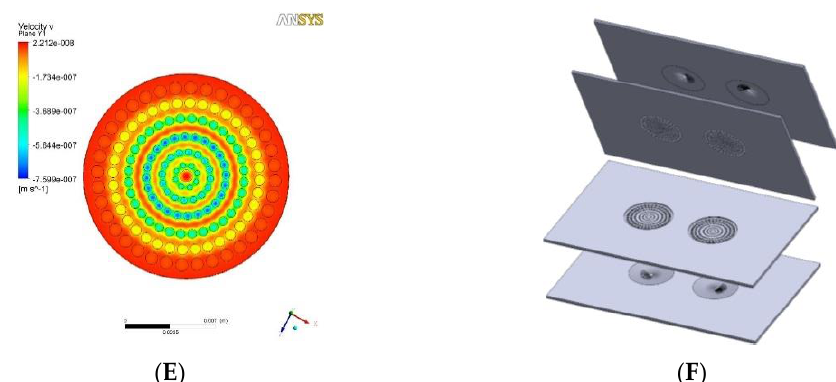
Figure 2. Flow distributor optimization: ( A ) Schematic design of testing chip which has sample collection channels starting along the diameter and was placed below the distributor to collect the perfusate. ( B ) In the case when hole size and positions are evenly distributed on the flow distributor, perfusion velocity was shown to be higher through the central sample holes than the periphery ones. ( C ) Simulation of flow velocity near the exit of the even-hole distributor at the overall flow rate of 0.1 mL h -1 . ( D ) Dimension of finalized flow distributor design. ( E ) Simulation of flow velocity near the exit of the finalized flow distributor. ( F ) Layer structure of the VfB (double well design as the prototype described here).